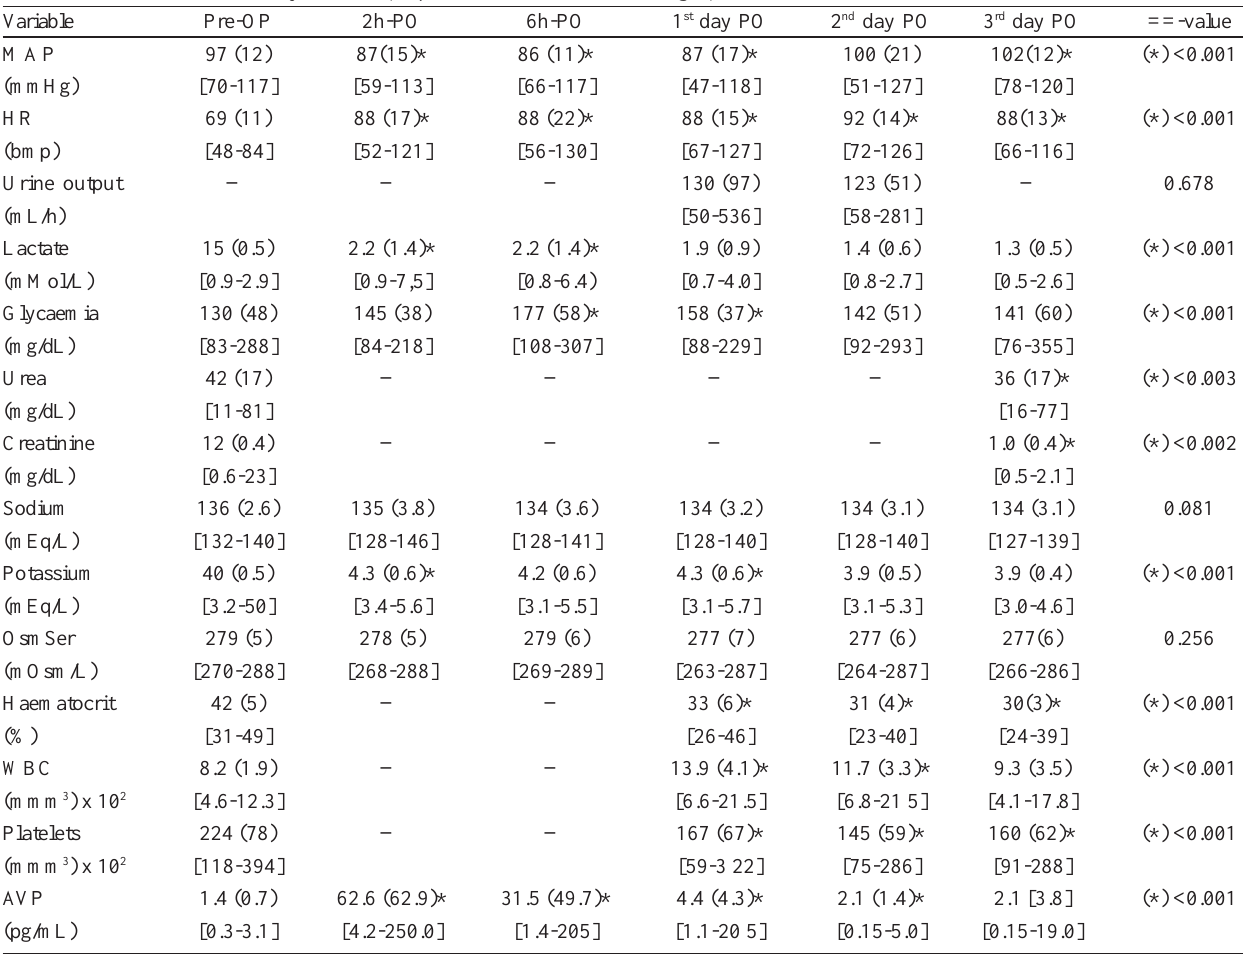
Table 2. Clinical and laboratory variables, expressed as mean (± SD) [Range], recorded at diferente observation times (n =